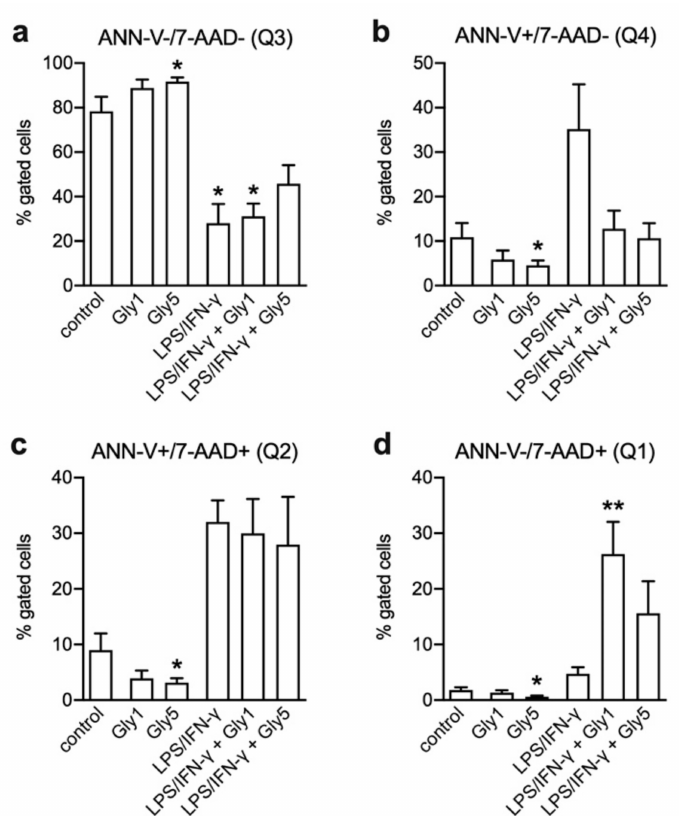
Figure 3. Determination of apoptotic cell fractions in BV-2 cells after 24 h without treatment (control), afterincubationwith1or5mMglycine(Gly1, Gly5), withLPS / IFN- γ aloneaswellaswithLPS / IFN- γ and 1 or 5 mM glycine. ( a ) Living cells (ANN-V- / 7-AAD-; Q3), ( b ) early apoptotic cells (ANN-V +/ 7-AAD-; Q4), ( c ) late apoptotic cells (ANN-V +/ 7-AAD + ; Q2) and ( d ) necrotic cells (ANN-V- / 7-AAD + ;